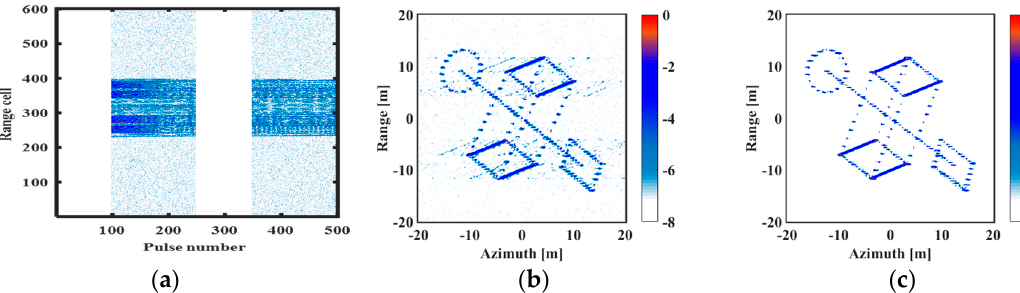
Figure 7. Range profiles and imaging results with RMS of 150 pulses: ( a ) Range profiles; ( b ) Imaging result of algorithm in [23]; ( c ) Imaging result of the proposed algorithm.